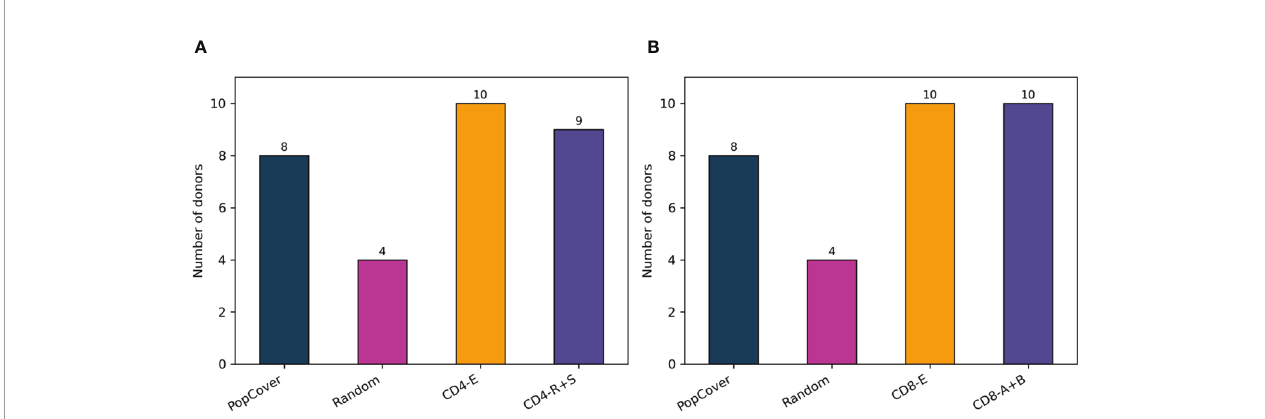
FIGURE 8 | Number of donors with CD4 (A) or CD8 (B) response to each peptide pool tested, based on measurements with background subtracted. PopCover: 15-mers selected by the PopCover method (10 peptides from each of the proteins S, N and ORF3a, N = 30). Random: 15-mers randomly selected (10 peptides from each of the proteins S, N and ORF3a, N = 30). CD4-E and CD8-E: experimentally derived epitopes from Tarke et al. (14). CD4-R+S: 15- mers overlapping by 10 spanning the spike protein combined with the 7-allele predicted epitopes based on the remainder of the SARS-CoV-2 proteome (N = 221 for R and N = 253 for S). CD8-A+B: peptide pool in the top 1 percentile selected by NetMHCpan 4.0 after prediction with 12 HLA class I alleles with Pf>6% (N =